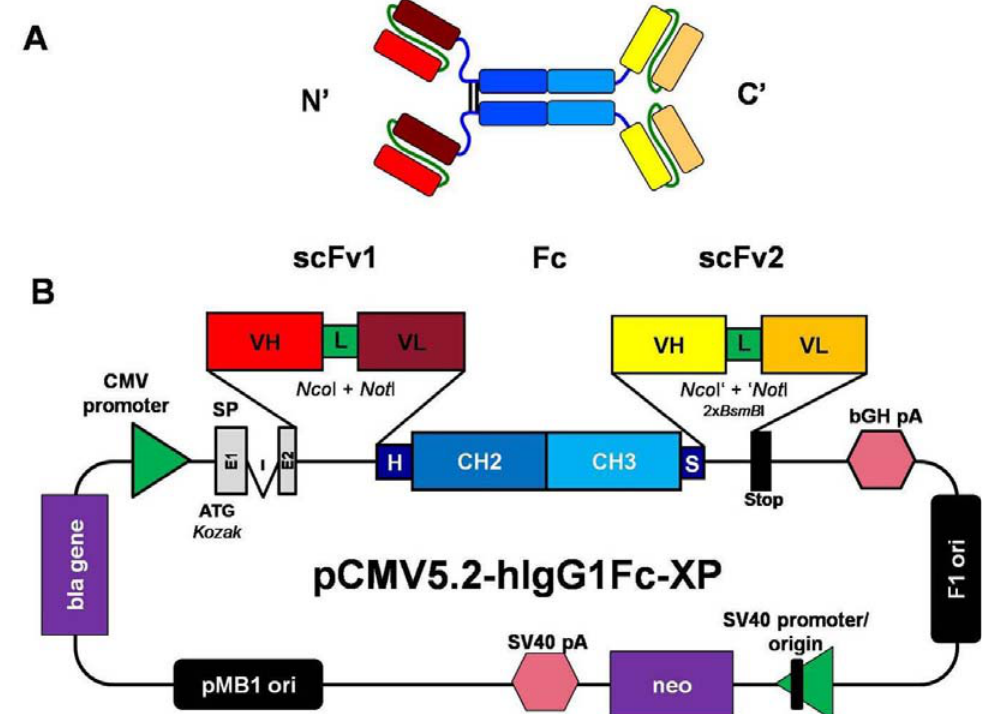
Figure 1. Schematic illustration of the scFv-Fc-scFv antibody format and the pCMV5.2- hIgG1Fc-XP vector. This mammalian expression vector contains a pCMV/myc/ER plasmid backbone, including the beta-lactamase (bla) gene, the pMB1 bacterial origin of replication (ori), the neomycin phosphotransferase (neo) expression cassette with simian virus (SV) 40 promoter/ori and poly A signal (pA) as well as an F1 phage origin. The antibody expression cassette is driven by a human CMV promoter and terminated by a bovine growth hormone (BGH) pA. The antibody gene constructs contain a leader sequence (SP) which consists of two exons (E1, E2) interrupted by an intron (I) for stabilized gene expression. The leader sequence is followed by an NcoI+NotI cloning cassette for the aminoterminal scFv1. Downstream there are gene fragments encoding the hinge (H), constant CH2 and CH3 regions of human IgG1-Fc and a short spacer sequence (S) followed by a second NcoI+NotI compatible cloning site formed by two BsmBI sites for the carboxyterminal scFv2. ScFv antibody fragments consist of variable heavy (V and light (V ) chains connected by soluble flexible linkers of at least 15 amino acids (L). L The schemes are not drawn to